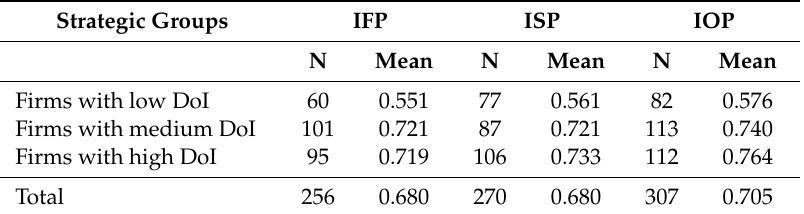
Table 6. Strategic groups’ means of the international performance dimensions. Strategic